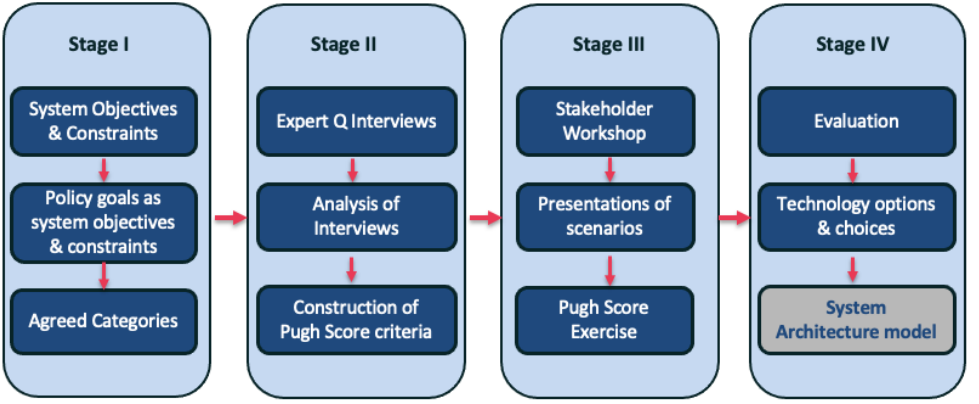
Figure 1. Staged design of the Stakeholder Requirements Process.